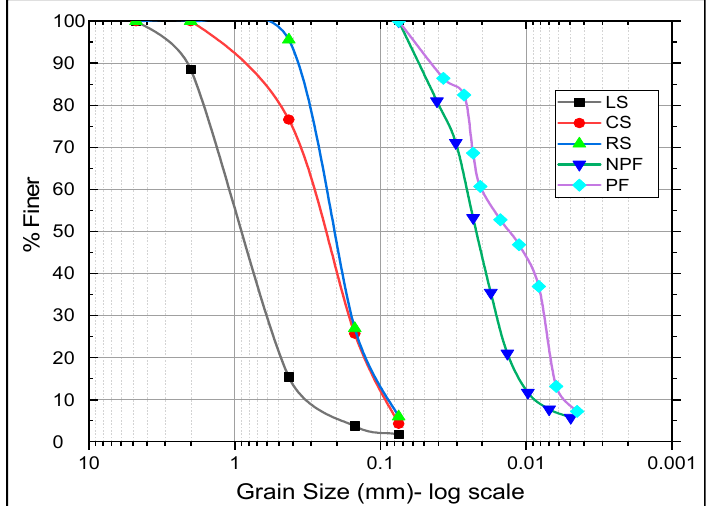
Figure 1. The gradation curves of three types of sands and two fines.